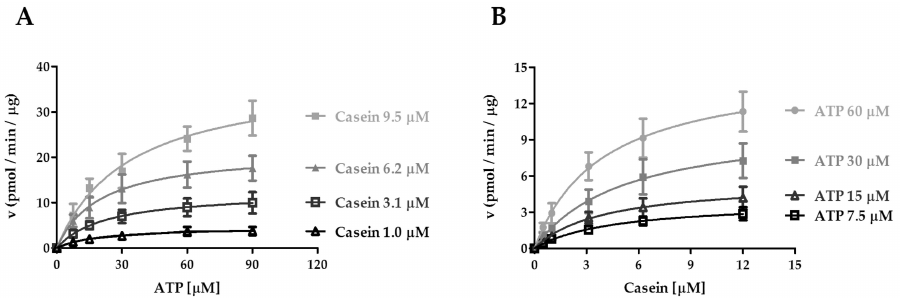
Figure 2. Kinetic analysis of CK1 ε acting on ATP and casein. ( A ) Kinetic analysis of CK1 ε towards ATP increasing concentrations at fixed casein concentrations. ( B ) Kinetic analysis of CK1 ε towards casein increasing concentrations at fixed ATP concentrations. In both cases, reaction velocity rate (y axis) is measured as picomoles of incorporated phosphate per minute per microgram of enzyme (pmol / min / µ g). Data are representative of three independent experiments. Bars indicate mean ± SD.